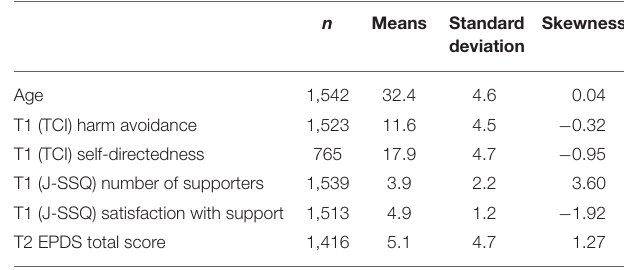
TABLE 1 | Summary of measured variables.